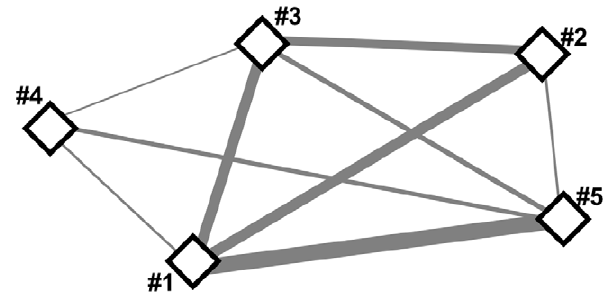
Figure 5. Network graph showing the example of the first Molossusmolossus colony (roost A) we radiotracked. Thickness of lines between individuals (diamonds) illustrates the number of times these two bats were found together. Number of co-observations range from 2 (between bats nr. 3 and 4) to 18 (between bats 1 and 5). Individual nr. 2 was a